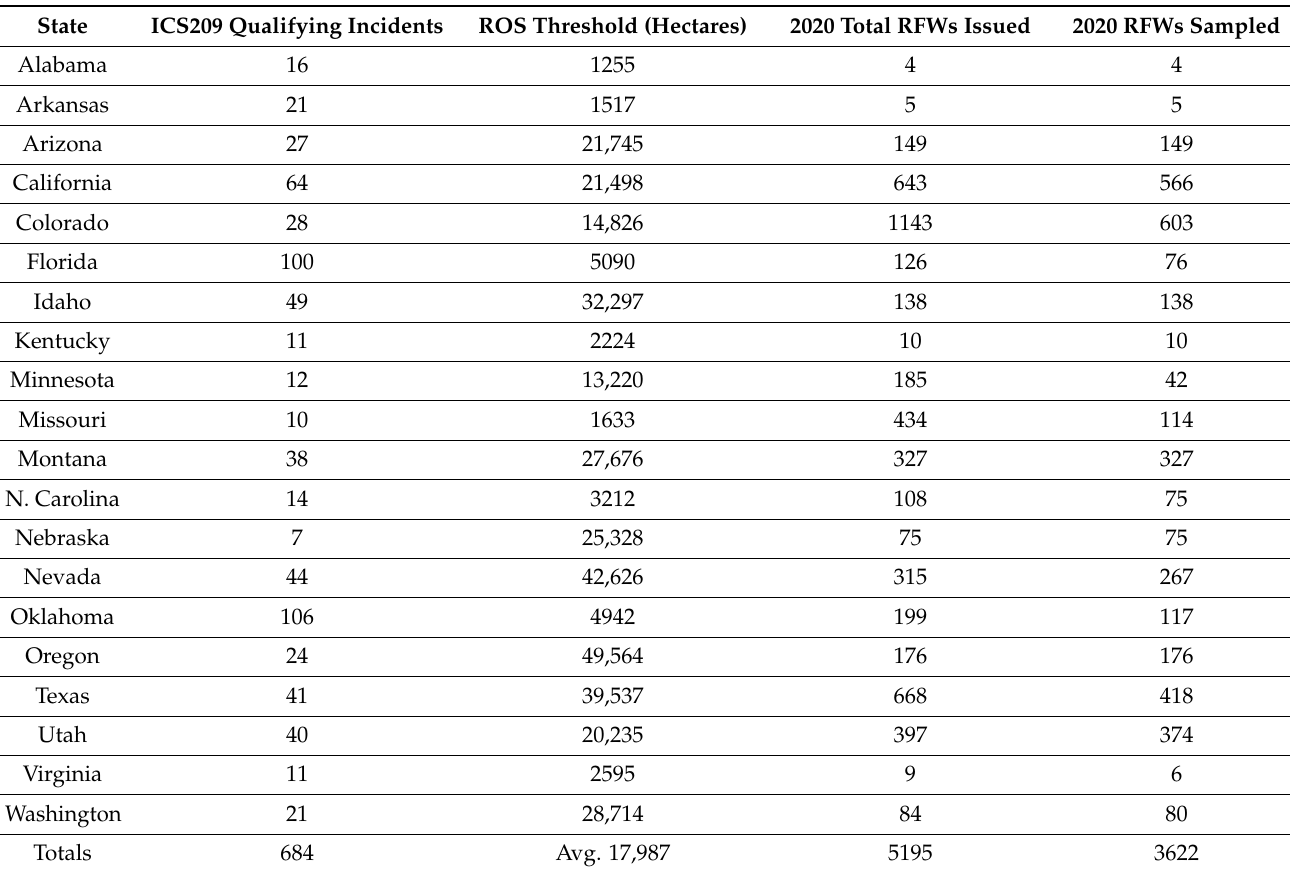
Table 1. Data sampled by state, including ICS209 incidents exceeding breakpoint rates of spread, total 2020 RFWs issued, and total 2020 RFWs corresponding to a FWZ with a RAWS station or a previous large fire